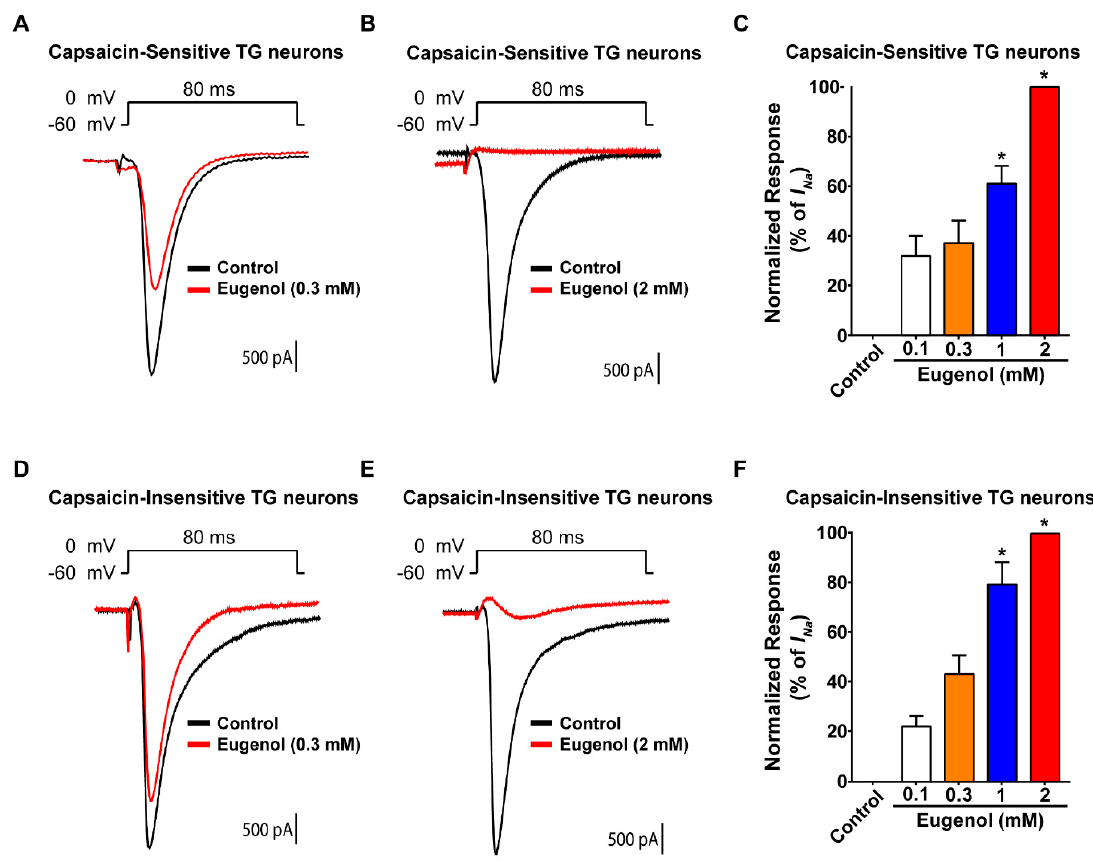
Figure 1. Effects of eugenol on voltage-gated sodium channel currents in small-sized TG neurons. Long-time base recordings of voltage-gated sodium channel (VGSC) currents measured during 80 ms-voltage steps from a holding potential of − 60 mV to a potential of 0 mV delivered every 3 s. ( A ) Representative VGSC current recording following the application of 0.3 mM eugenol and ( B ) 2 mM eugenol. ( C ) Percentage inhibition of VGSC currents by eugenol in capsaicin-sensitive TG neurons (from 0.1 to 2 mM, n = 37). ( D ) Representative VGSC current recording following the application of 0.3 mM eugenol and ( E ) 2 mM eugenol. ( F ) Proportion of VGSC current inhibition effected by eugenol (from 0.1 to 2 mM, n = 29) in capsaicin-insensitive TG neurons. * p < 0.05 versus control (no treatment).